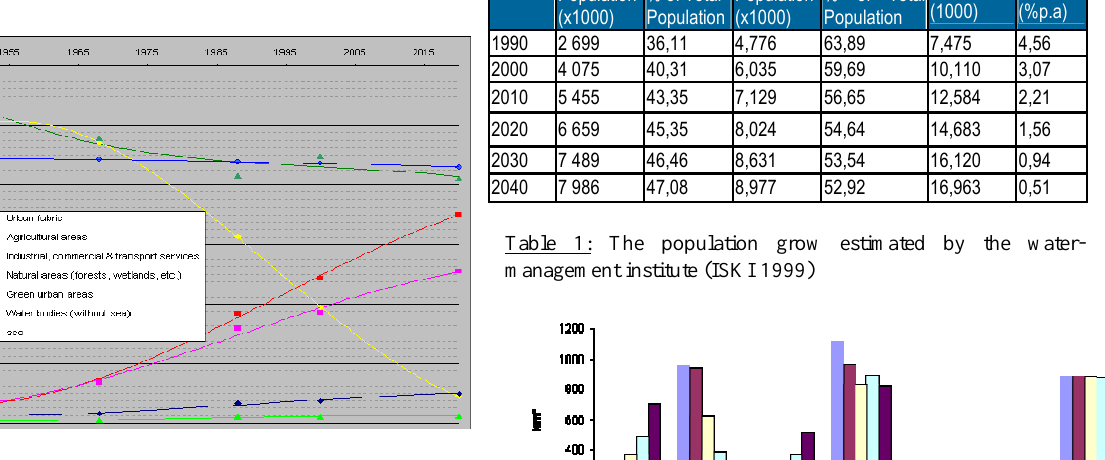
Figure 7: Estimated development up to the year 2020 by combined polynomial and linear regressions with smoothing and balancing to the total size